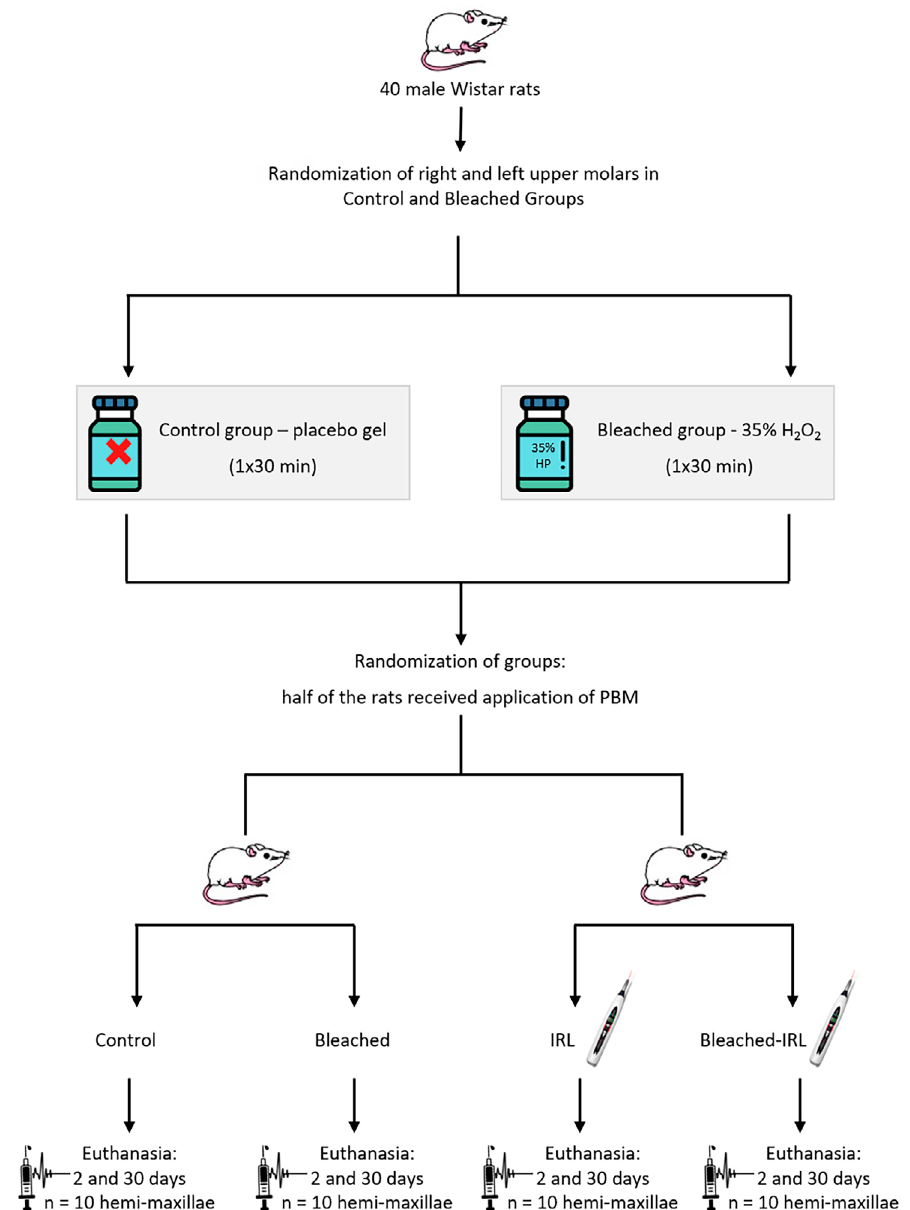
Figure 1- Diagram showing the distribution and randomization of rats in each